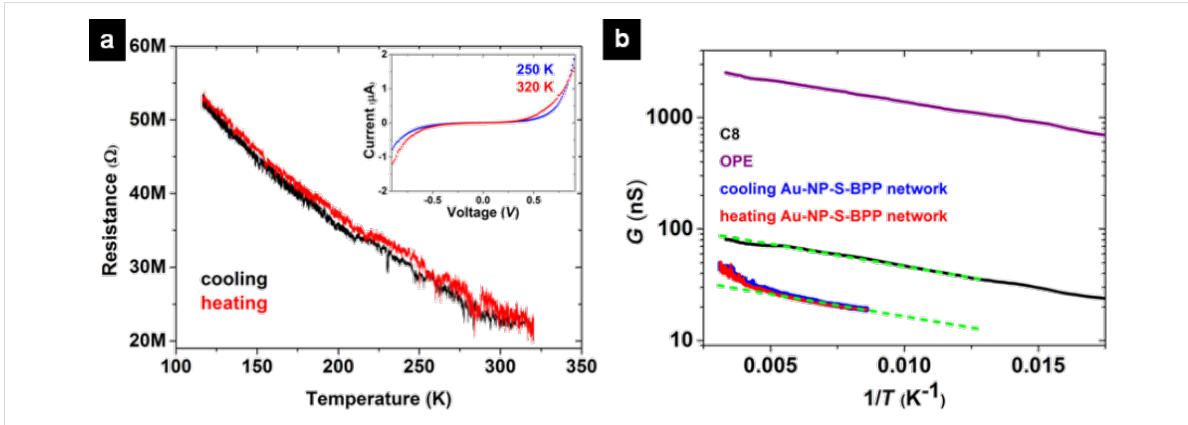
Figure 5: a) Low-bias resistance of a multilayered Au-NP–S-BPP network as a function of the temperature for 116 K < T < 320 K. Both cooling (black) and heating (red) traces are shown. Inset shows I – V curves of multilayered Au-NP–S-BPP network at 250 K and 320 K; b) Arrhenius plot (semilog plot of G vs 1/ T ) of the data in Figure 5a compared to experiments on similar, i.e., three times stamped, C8 networks (black) and OPE-bridged networks (purple). The green dashed lines are parallel guides to the eye to compare the slope of various